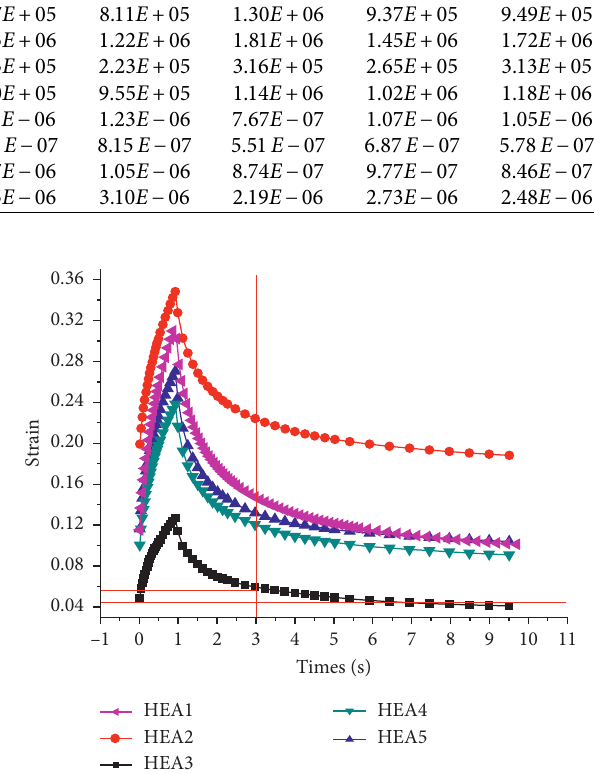
Table 2: Fitting parameters of the Burgers rheological model with different high-elasticity modified asphalt. Parameters